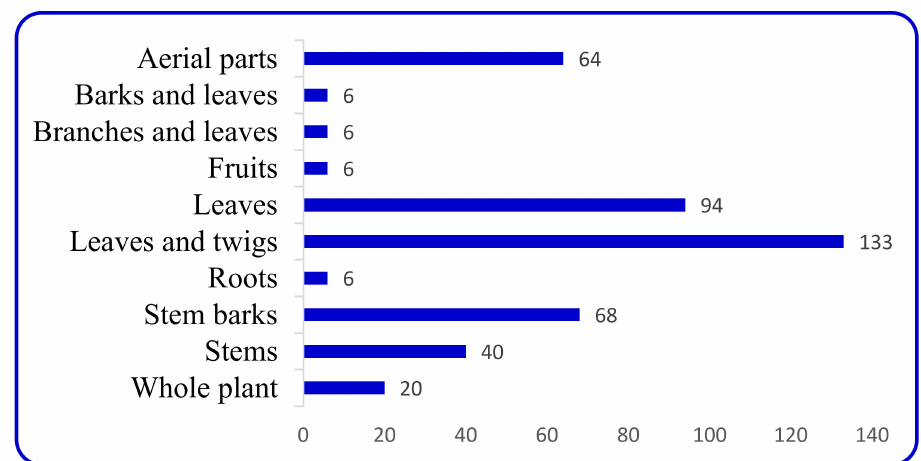
Figure 36. Number of compounds identified from different organs.